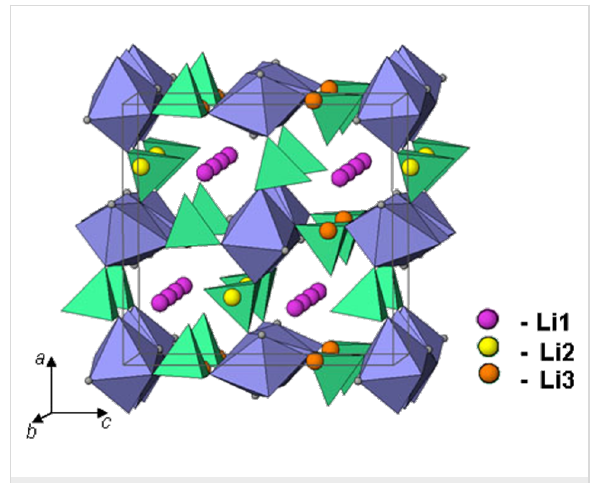
Figure 1: Crystal structure of 3D-Li 2 MPO 4 F, positions of Li atoms are denoted.